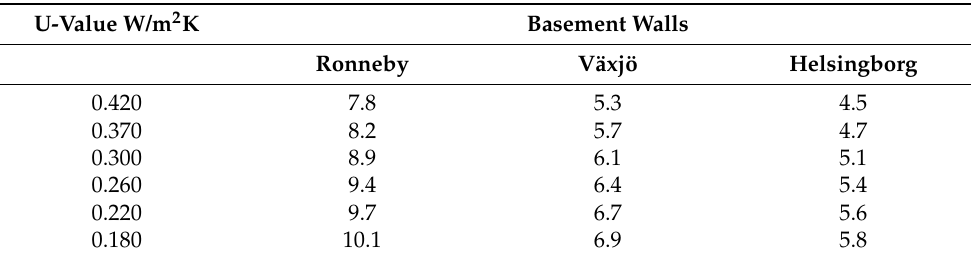
Table 11. Primary energy savings (kWh/m 2 /year) of extra insulation on basement walls under different scales of district heating systems.